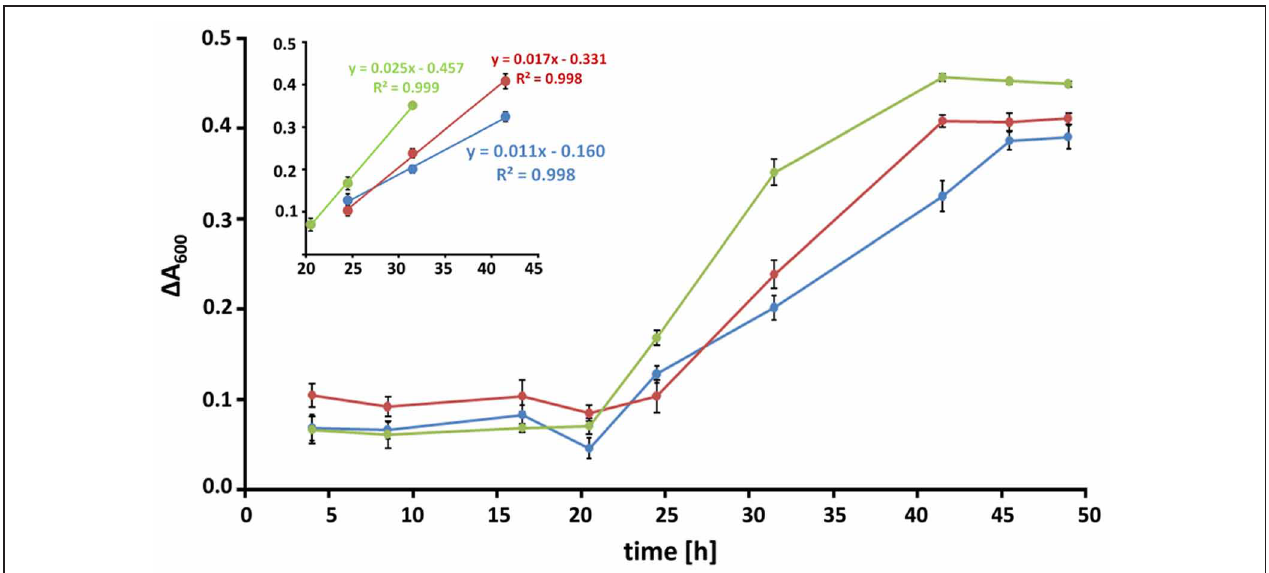
absorbance at a wavelength of 600nm. Data are expressed as the change in absorbance relative to an untreated control and represent the means and SDs of a biological triplicate. Time periods of linear growth kinetics for all three conditions are displayed in the